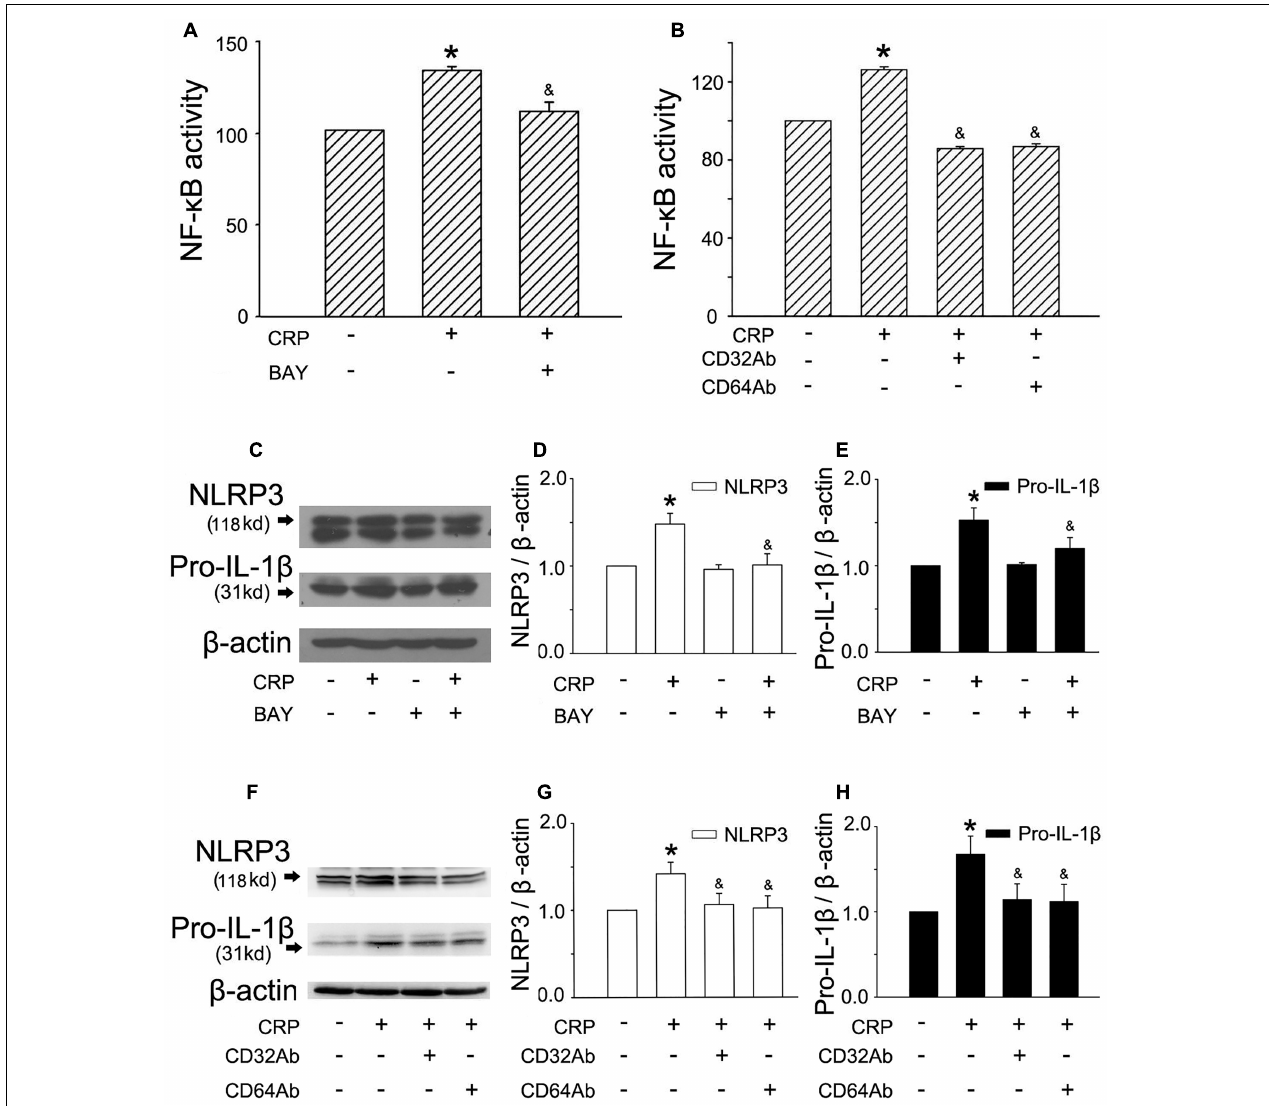
FIGURE 2 | Fc γ Rs and NF- κ B are involved in CRP-mediated NLRP3 and pro-IL-1 β expression. HUVECs were incubated with 1 µ mol/L BAY for 1 h, and then were treated in the absence or presence of 20 µ g/mL CRP for 24 h (A,C) . HUVECs were incubated with 10 µ g/mL CD32Ab, or 10 µ g/mL CD64Ab for 2 h, and then were treated in the absence or presence of 20 µ g/mL CRP for 24 h (B,F) . (A,B) NF- κ B activity was assayed. (C,F) Representative western blots showing the expression of NLRP3 and pro-IL-1 β . (D , E , G , H) Summary bar graphs showing the expression of proteins. ∗ P < 0.05 vs. Ctr; & P < 0.05 vs. CRP; n = 4.